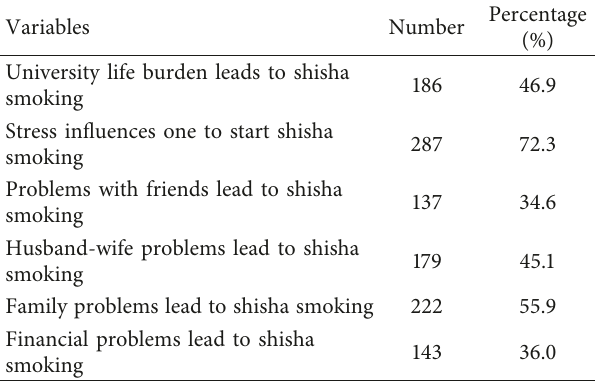
Table 4: Psychological factors involved in shisha